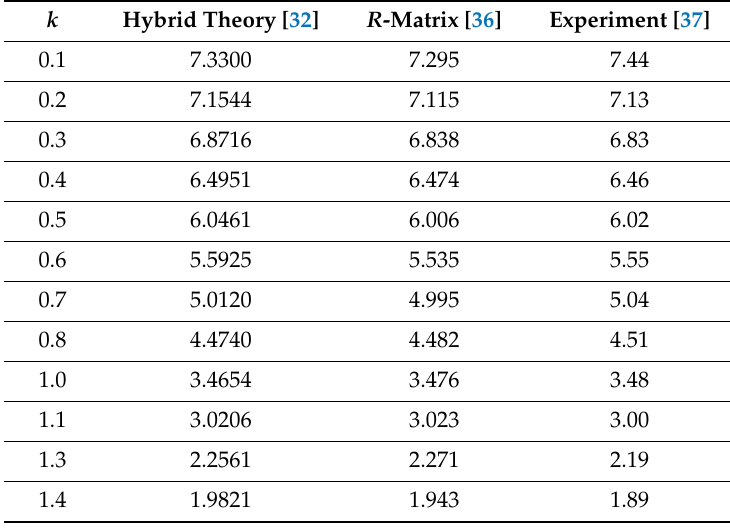
Figure 1. (Color online) Photodetachment cross-sections of a negative hydrogen ion in various approximations. The lowest curve is obtained when only long-range correlations are included, the middle curve is obtained when the short-range correlations are also included. The top curve represents the cross-sections obtained using Equation (26).